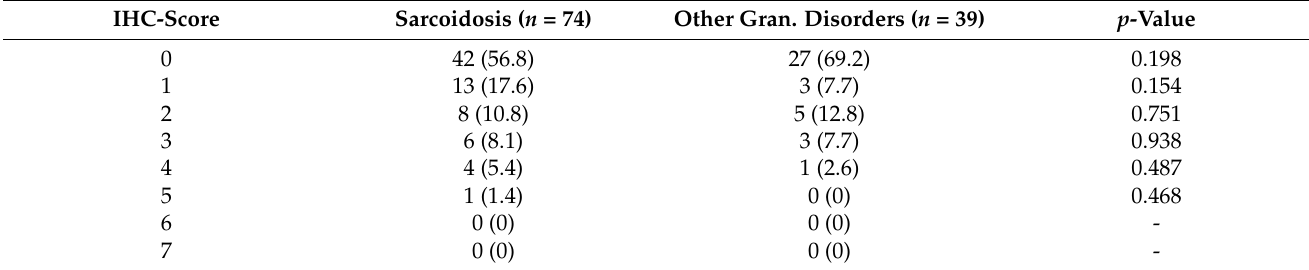
Figure 2. p-S6 (S6K activity) immunohistochemistry (IHC) staining in sarcoidosis tissue ( A ) Hematoxylin-eosin (HE) staining of tissue from lymph node, ( B ) negative staining of tissue from lung, ( C ) weak staining of tissue from lung, ( D ) moderate staining of tissue from lymph node, and ( E ) strong staining of tissue from skin. Table 1. Immunohistochemical (IHC) scoring of percentage of p-S6 positive cells within the granuloma of sarcoidosis patients and of patients with other granulomatous disorders, ranging from 0 to 7. Data are shown as absolute numbers with percentage in